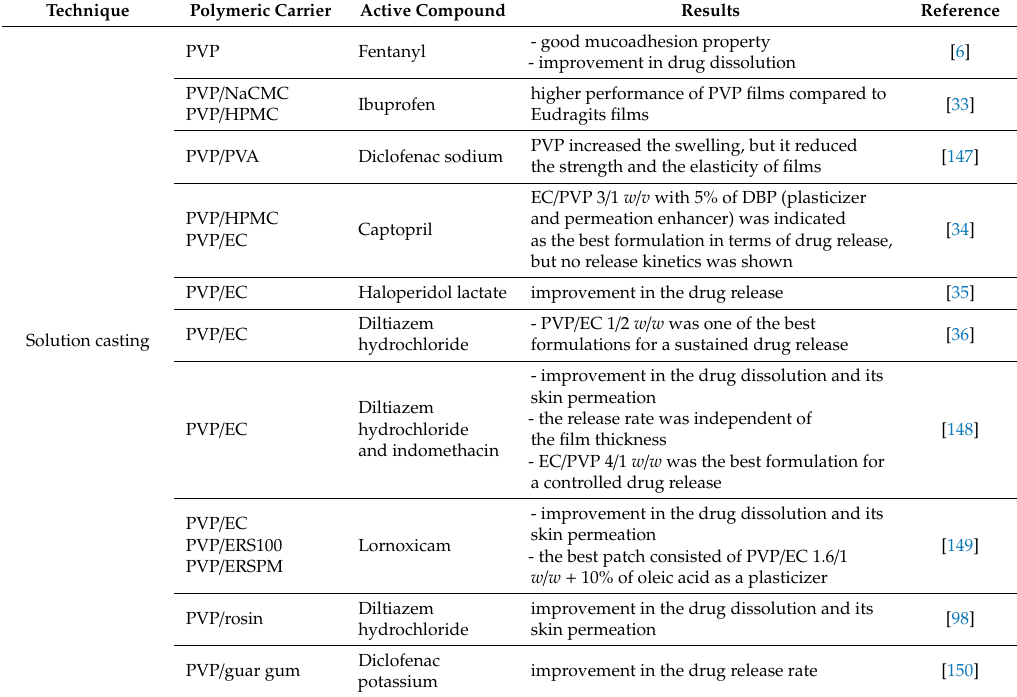
Table 5. PVP-based films. NaCMC, carboxymethylcellulose sodium salt; HPMC, hydroxypropyl methylcellulose; PVA, polyvinyl alcohol; EC, ethyl cellulose; DBP, dibutyl phthalate; ERS100, Eudragit RS100; ERSPM, Eudragit RSPM.